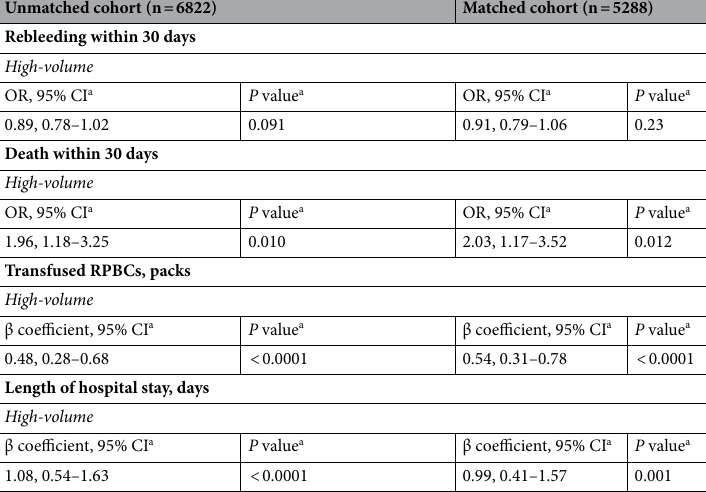
Table 4. Association with rebleeding and death within 30 days, the amount of PRBCs, and length of hospital stay in the unmatched and the matched cohorts. a Adjusted for patients’ characteristics used for the construction of propensity scores. A two-tailed P -value < 0.05 was considered to indicate statistical significance. OR odds ratio, CI confidence interval, PRBCs packed red blood